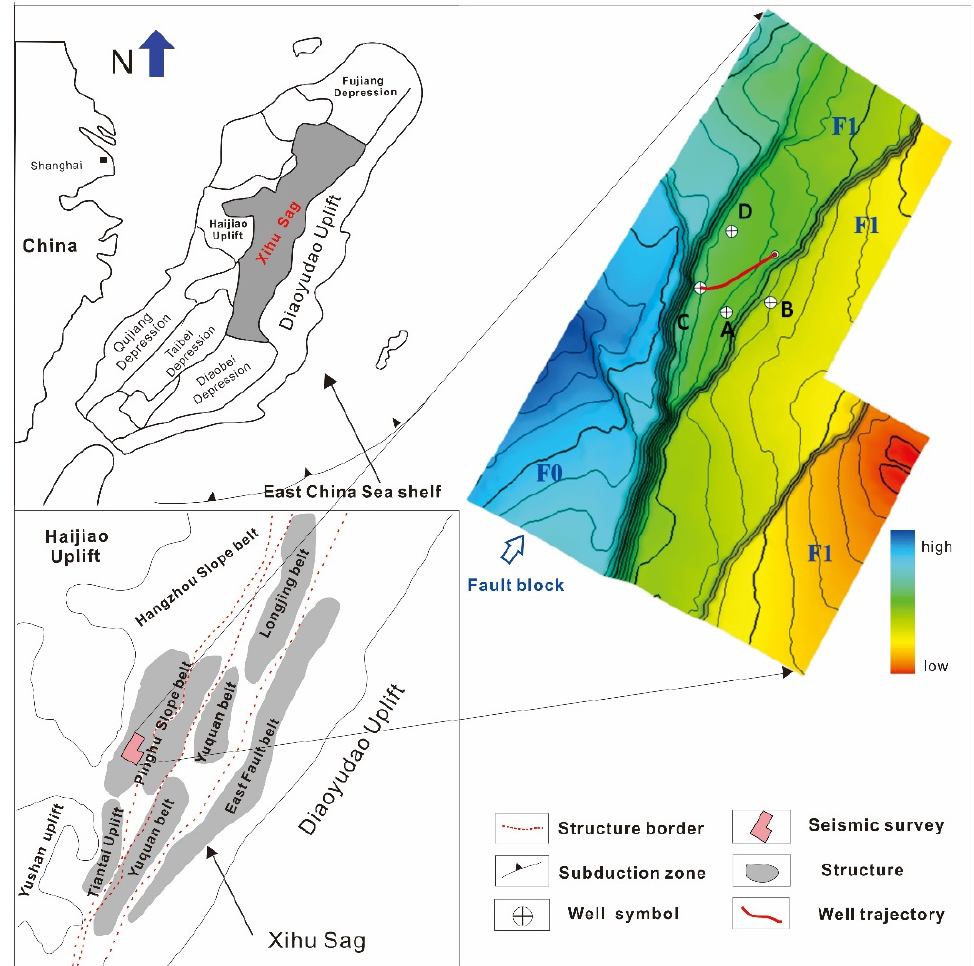
Figure 1. Index map showing the study area.